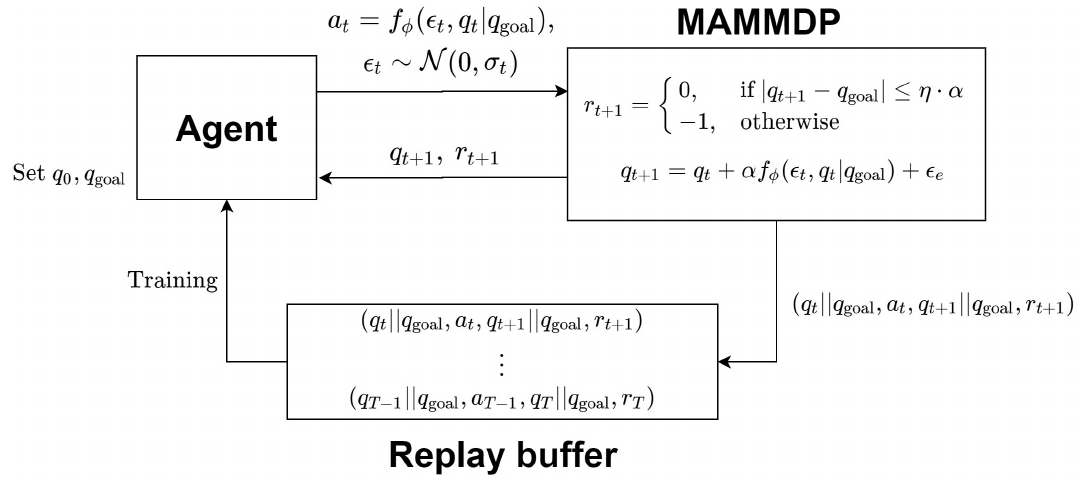
Figure 1. Multi-Arm Manipulator Markov Decision Process